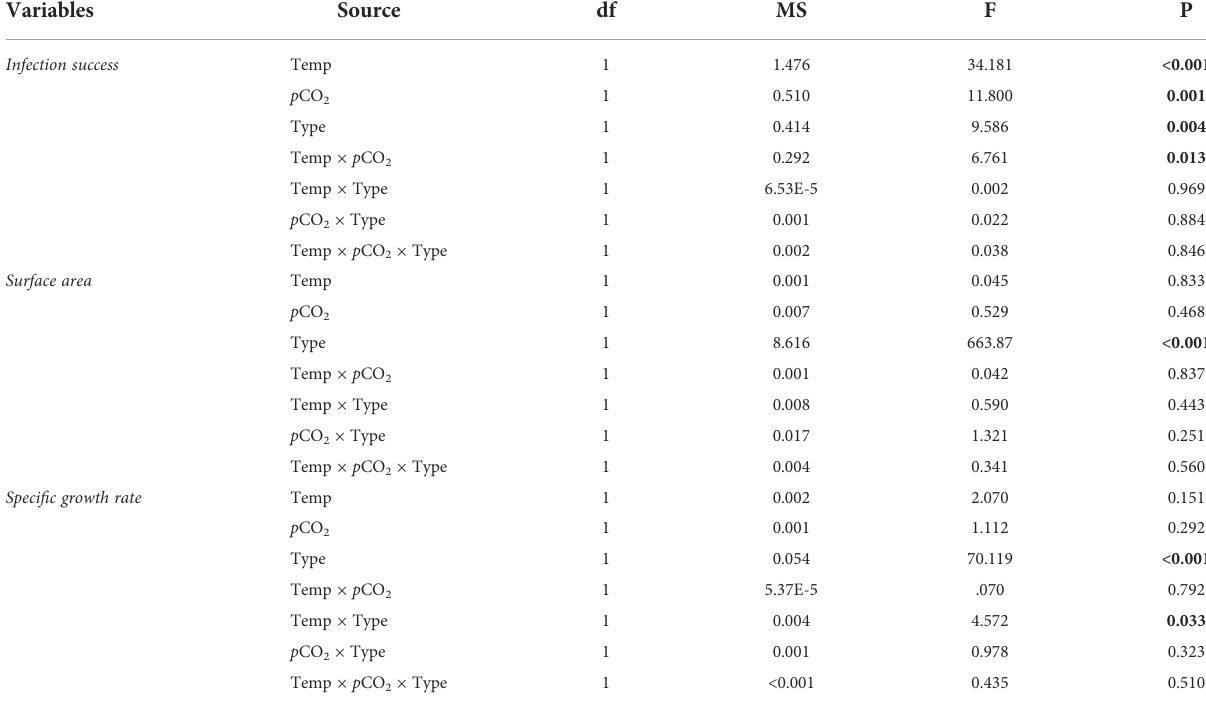
TABLE 2 Statistical results of three-way ANOVAs on the effects of temperature (28 vs . 30.5°C), p CO 2 (~500 vs . ~1000 m atm) and recruit type (chimera vs . single) on the physiological responses of Acropora austera recruits. Variables